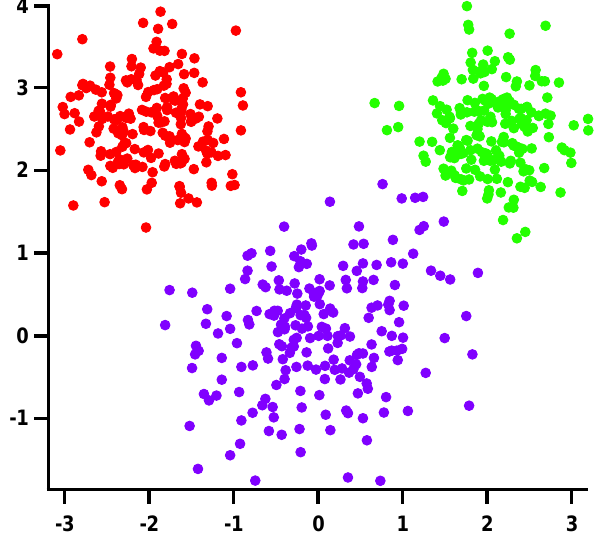
Fig. 3. Cluster analysis results, three-cluster solution. Each cluster indicated by colour. Three separate groups are resolved.